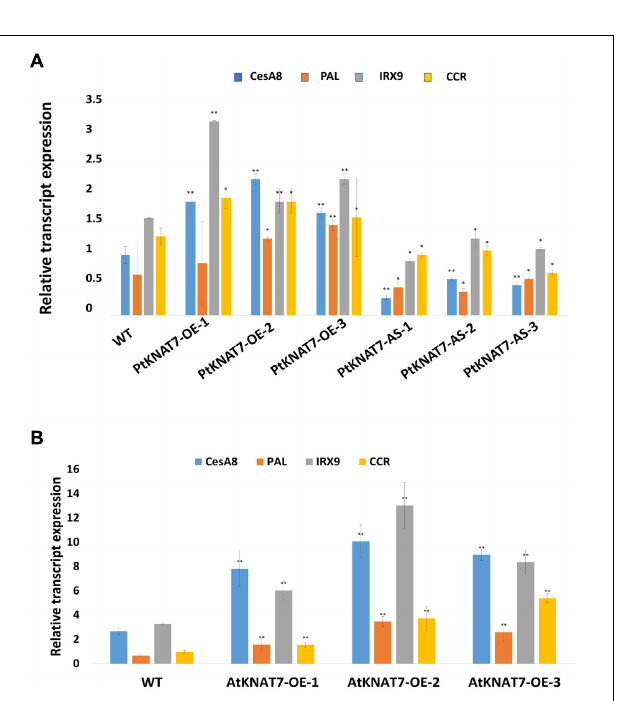
FIGURE 2 | Effect of KNAT7 transgene expression on four selected SCW biosynthetic genes in poplars, namely, CesA8, PAL, IRX9 , and CCR . (A) SCW gene expressions patterns in PtKNAT7-OE and PtKNAT7-AS transgenic lines. (B) SCW gene expressions patterns in AtKNAT7-OE transgenic lines. Bars represent the average of three replicates of three transgenic lines. All differences were significant when compared to WT